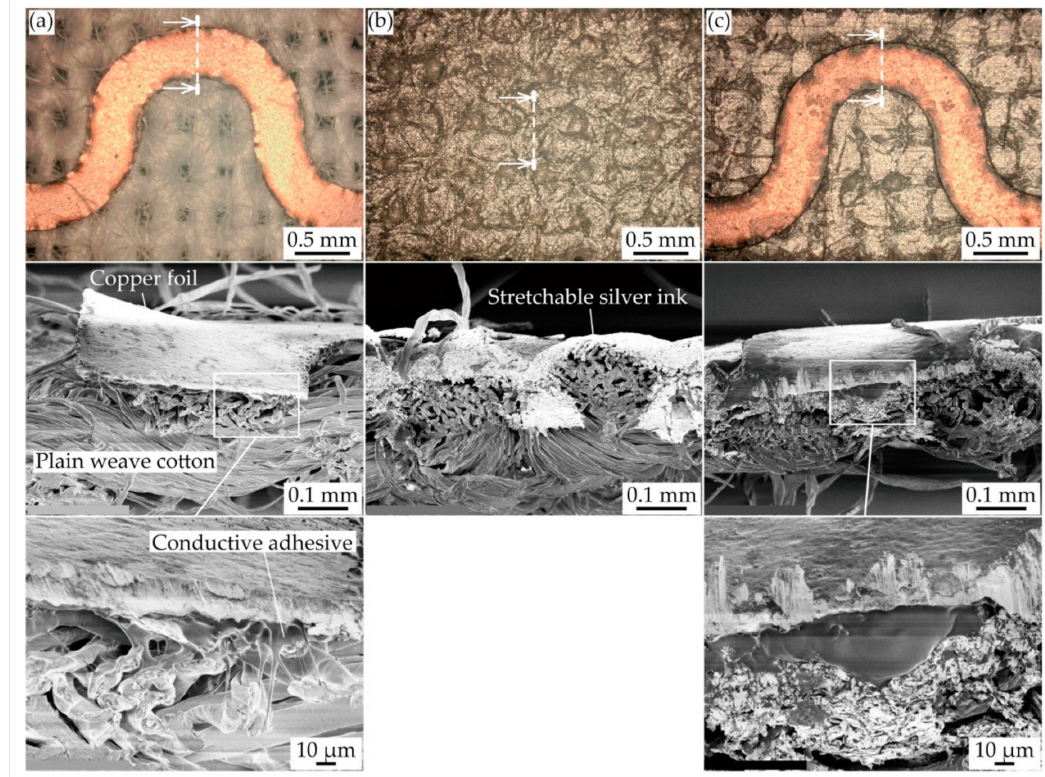
Figure 4. Optical and cross-sectional SEM images of ( a ) meandering copper; ( b ) silver ink; and ( c ) double-layered